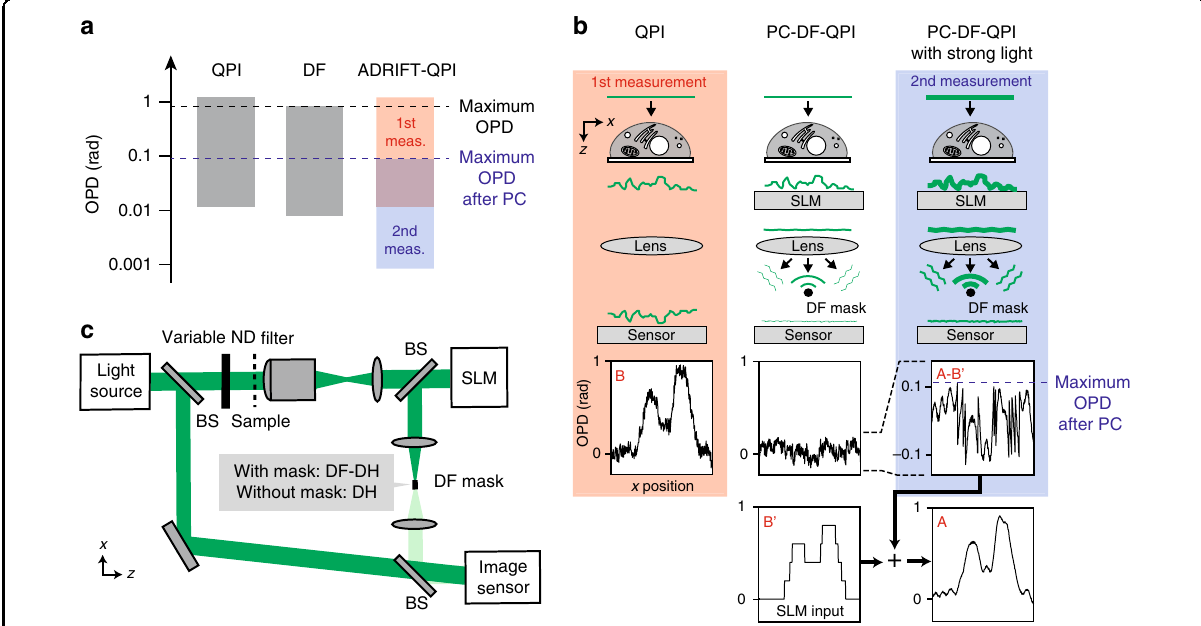
Fig. 1 Principle of ADRIFT-QPI. a Dynamic range of phase imaging: (left) conventional QPI, (centre) dark- fi eld imaging, (right) ADRIFT-QPI. We assume a standard CMOS image sensor where a full well capacity of ~10,000 e − /pixel is used. b Principle of dynamic range expansion in ADRIFT-QPI. The left column shows the fi rst measurement, where the large-OPD distribution of the sample (B) is measured by QPI with plane wave illumination. The centre column shows the situation of PC-DF-QPI where the DF mask blocks the unscattered light by phase cancellation with the SLM. The right column shows the second measurement, which is PC-DF-QPI with strong light illumination, allowing for dynamic-range-shifted highly sensitive measurement. The dynamic-range-expanded OPD distribution of the sample (A) can be computationally reconstructed by adding the PC-DF-QPI measurement result (A – B ′ ) to the SLM input OPD map (B ′ ). c Optical implementation of ADRIFT-QPI. In this work, off-axis DH is used as a QPI technique. DH and DF-DH are switchable in a single setup by insertion/removal of the DF mask. The phase-only SLM is placed in the sample conjugate plane for wavefront shaping, while the DF mask is placed in the Fourier plane for spatially fi ltering the unscattered light. The illumination light intensity on the sample can be changed with a neutral density (ND) fi lter placed in front of the sample. BS: